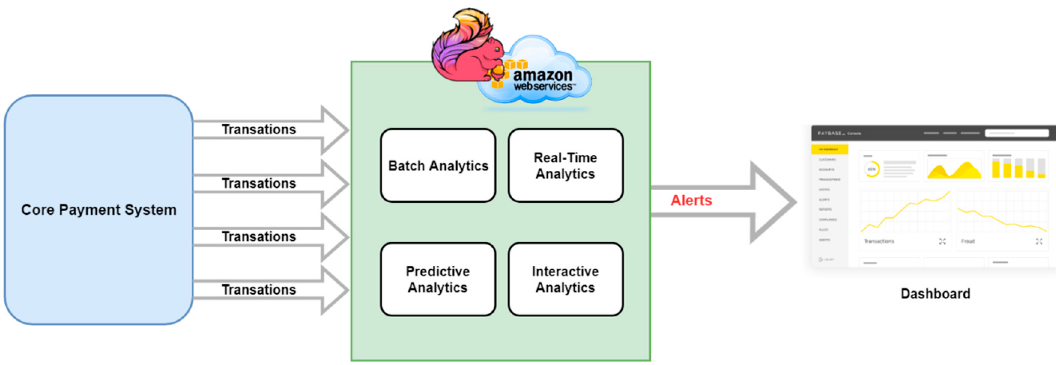
Figure 1. Fraud detection and prevention system based on Amazon and Apache Flink.